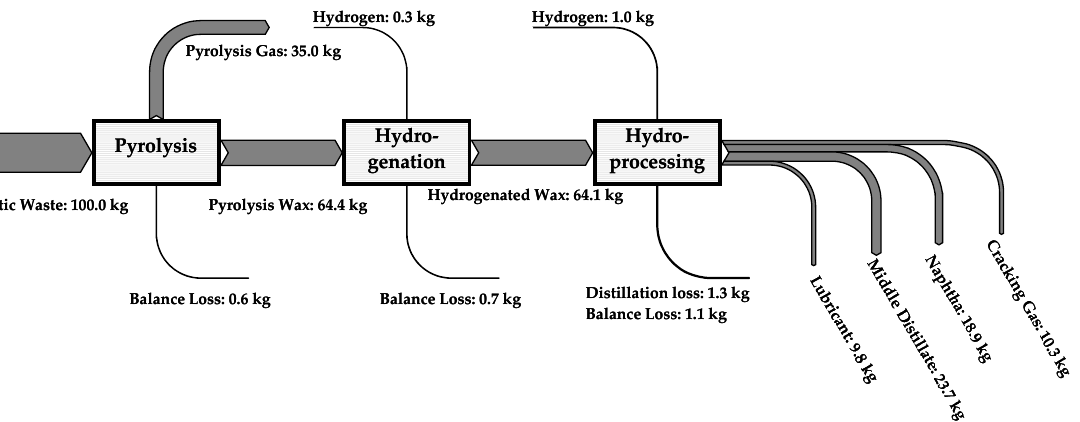
Figure 8. Flow diagram of product yield for catalytic treatment of agricultural films for conditions of HP 370 °C.